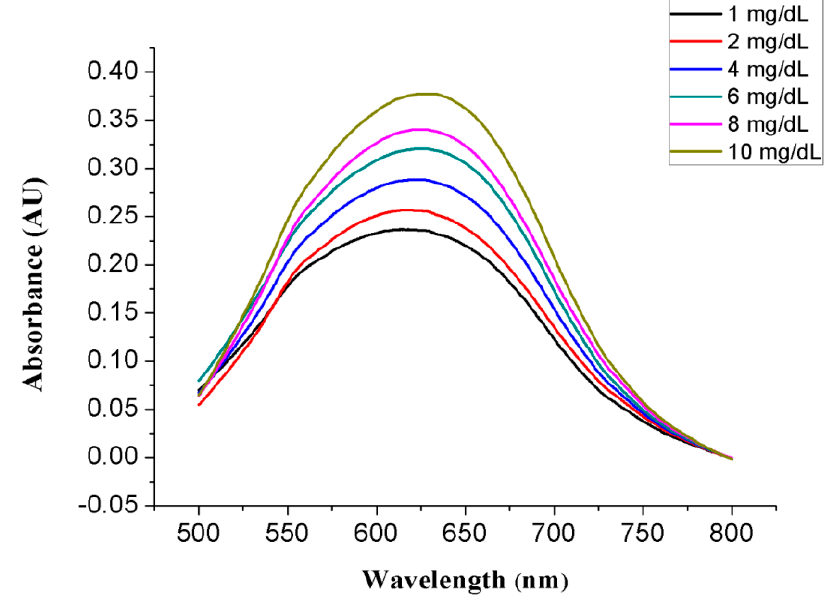
Figure 9. Measured absorbance of colorized sample with different concentrations using a UV-Vis spectrometer.